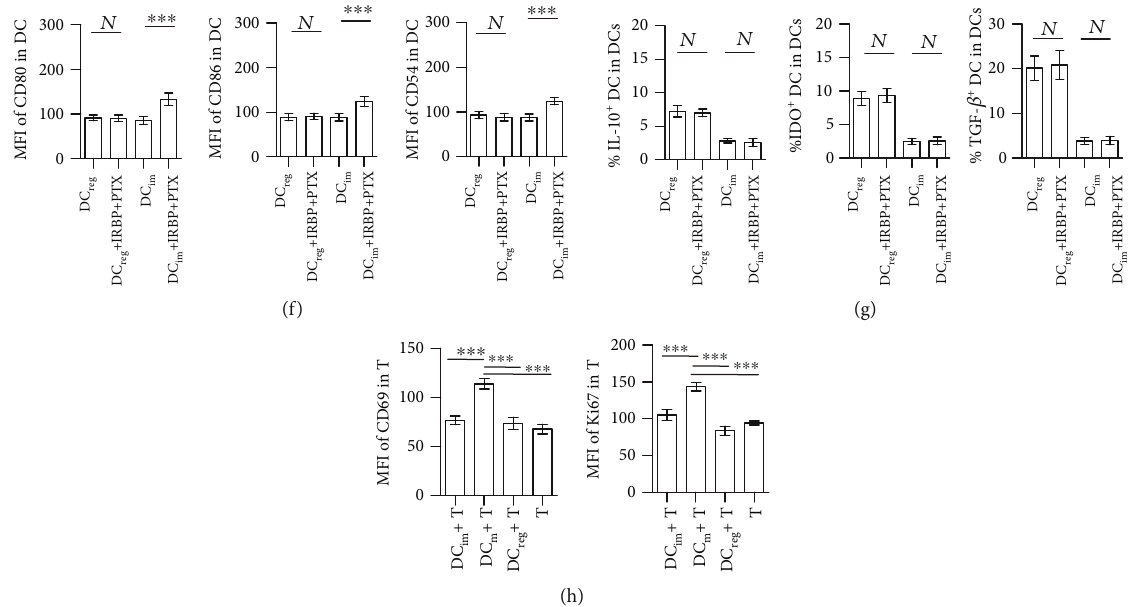
Figure 1: The states of I-a low CD11b high DCs in the eyes of EAU. (a) The representative diagram of I-a low CD11b high DCs (DC a high CD11b low DCs (DC ) in the eyes of EAU after being immunized for 28 days. (b) Dynamic change of percentage of DC in CD45 + m cells in the eyes of EAU. (c) Dynamic change of percentage of DC and DC in CD45 + cells in the eyes of EAU. Three mice were used reg m for every group; the experiment was replicated three times; data were presented as mean ± standard errorof the mean (SEM), Kruskal- Wallis test, and ∗∗∗ P < 0 : 001 and ∗∗ P < 0 : 01 . (d) The expression of CD80, CD86, and CD54 on I-a low CD11b high DCs (DC a low CD11b low DCs (DC ), and I-a high CD11b low DCs (DC ). MFI is the mean intensity of fl uorescence of molecules on the surface of im m DCs. (e) The representative intracellular cytokines in DC (upper panels) and the expression of intracellular cytokines in DC reg compared with those in DC and DC . (d, e) DC , DC , and DC were isolated from the eyes of EAU, and experiments were im m reg im m replicated three times; data were presented as mean ± standard errorof the mean (SEM) and ∗ P < 0 : 05 , ∗∗ P < 0 : 01 , and ∗∗∗ P < 0 : 001 . (f) The surface expression of CD80, CD86, and CD54 in DC and DC , which were stimulated by 10 ng/ml of IRBP reg im PTX (to induce maturation) for 24-48h, was measured by fl ow cytometry. The mean fl uorescence intensity (MFI) is shown as mean ± standard errorof themean (SEM) from three separate experiments. (g) The percentage of IL-10 + DCs, IDO + DCs, or TGF- β + DCs in or DC , which were stimulated by IRBP and PTX. (h) Isolated DC promoted CD4 + T cells to express a higher level of CD69 and DC reg im m Ki67 than DC or DC did. (f – h) were analyzed with one-way ANOVA test. ∗∗∗ P < 0 : 001 ; N is not signi fi cantly di ff reg im